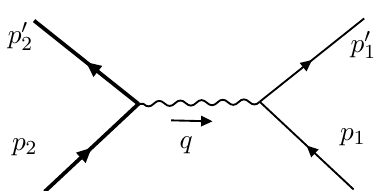
Figure 1. Tree-level scattering amplitude A (0) between the spin- S , labeled by 2 , and the scalar particle, labeled by 1 . The wiggly line is either a photon or a